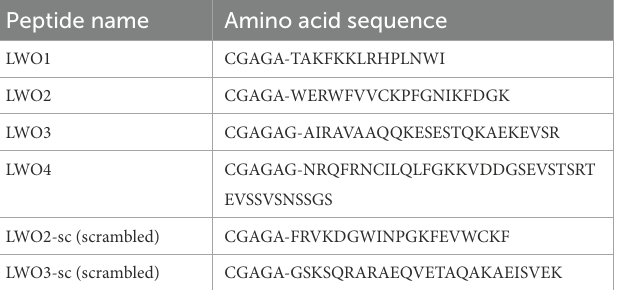
TABLE 1 Amino acid sequences of the LWO peptides used in the present